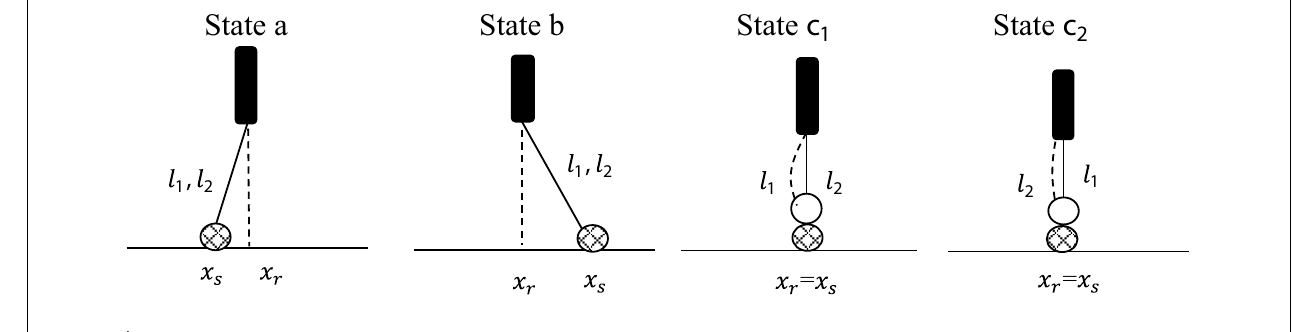
FIGURE 1 | Representation of the two leg states a and b and the two leg-over-leg states c 1 and c 2 . The walking direction is from left to right. For simplicity, we present in this diagram each